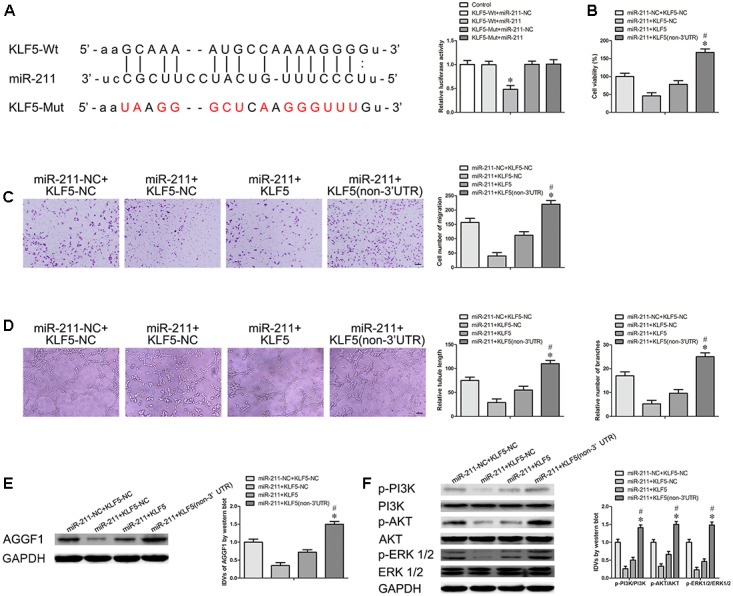
miR-211 inhibited GBM angiogenesis via regulating PI3K/AKT and ERK1/2 pathways by targeting to KLF5 3′-UTR. (A) The predicted miR-211 binding site in KLF5 and the designed mutant sequences were indicated. Dual-luciferase report assay of HEK 293T cells co-transfected with KLF5-Wt and miR-211-NC or KLF5-Wt and miR-211, and KLF5-Mut and miR-211-NC or KLF5-Mut and miR-211. Data are presented as mean ± SD. (n = 5, each group), ∗P < 0.05 vs. KLF5-Wt + miR-211-NC group. (B) CCK-8 assay was performed to evaluate the effect of miR-211 and KLF5 on GECs proliferation. (C) Effect of miR-211 and KLF5 on quantification number of GECs migration. (D) Effect of miR-211 and KLF5 on GECs tube formation. Data are presented as mean ± SD. (n = 5, each group), ∗P < 0.05 vs. miR-211+KLF5 group; #P < 0.05 vs. miR-211+KLF5-NC group. (E) The effect of miR-211 and KLF5 on expression of AGGF1 by Western blot assay. (F) Western blot analysis of p-PI3K, PI3K, p-AKT, AKT, p-ERK1/2, and ERK1/2 regulated by miR-211 and KLF5 in GECs, shown using GAPDH as endogenous control. Data are presented as mean ± SD. (n = 5, each group), ∗P < 0.01 vs. miR-211+KLF5 group; #P < 0.01 vs. miR-211+KLF5-NC group. Scale bars represent 30 μm.